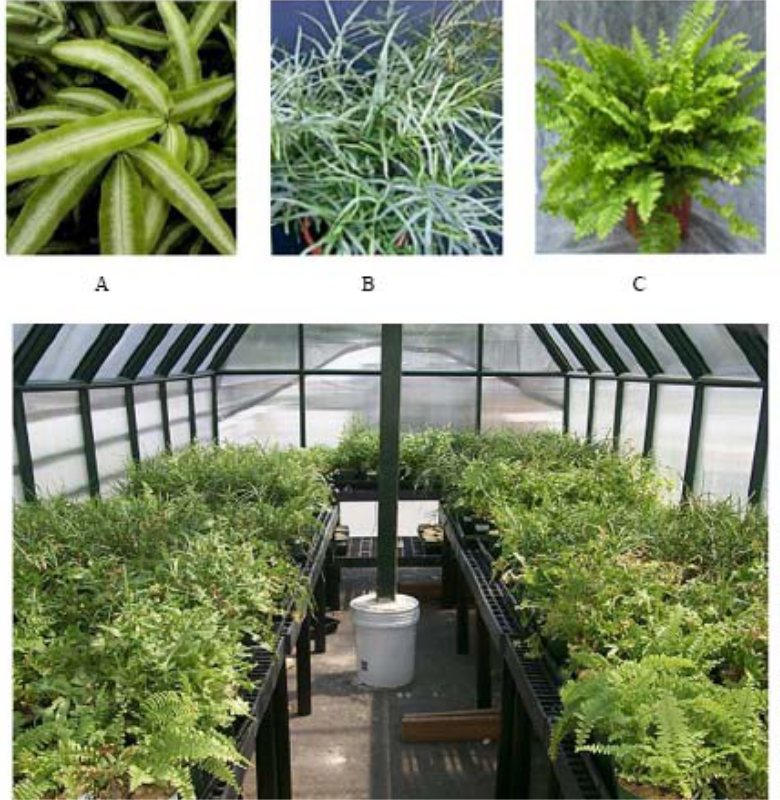
Figure 2. The ferns used in this experiment: A) Pteris cretica mayii , B) Pteris multifida , C) Nephrolepis exalta , D) all ferns growing in the greenhouse. Figures A, B and C used by permission of Heaton’s Nursery,